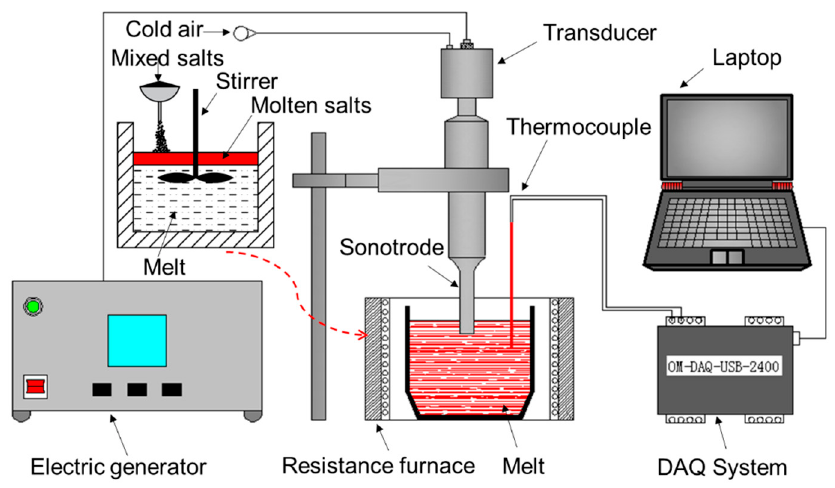
Figure 1. Schematic diagram of experiment.